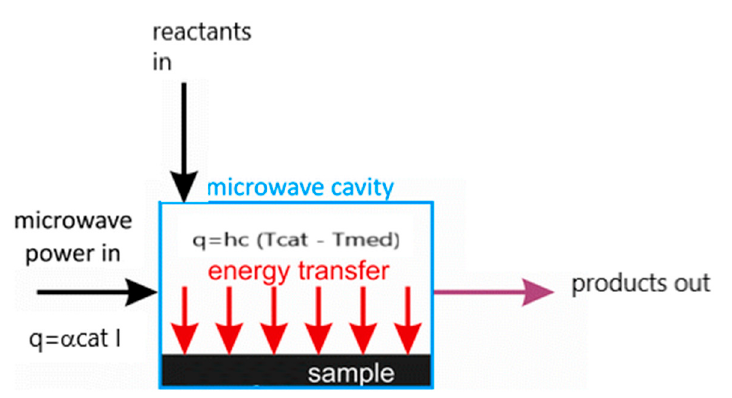
Figure 4. Synthetic sketch of the heat transfer pathways in a microwave-assisted heterogeneous catalytic system.